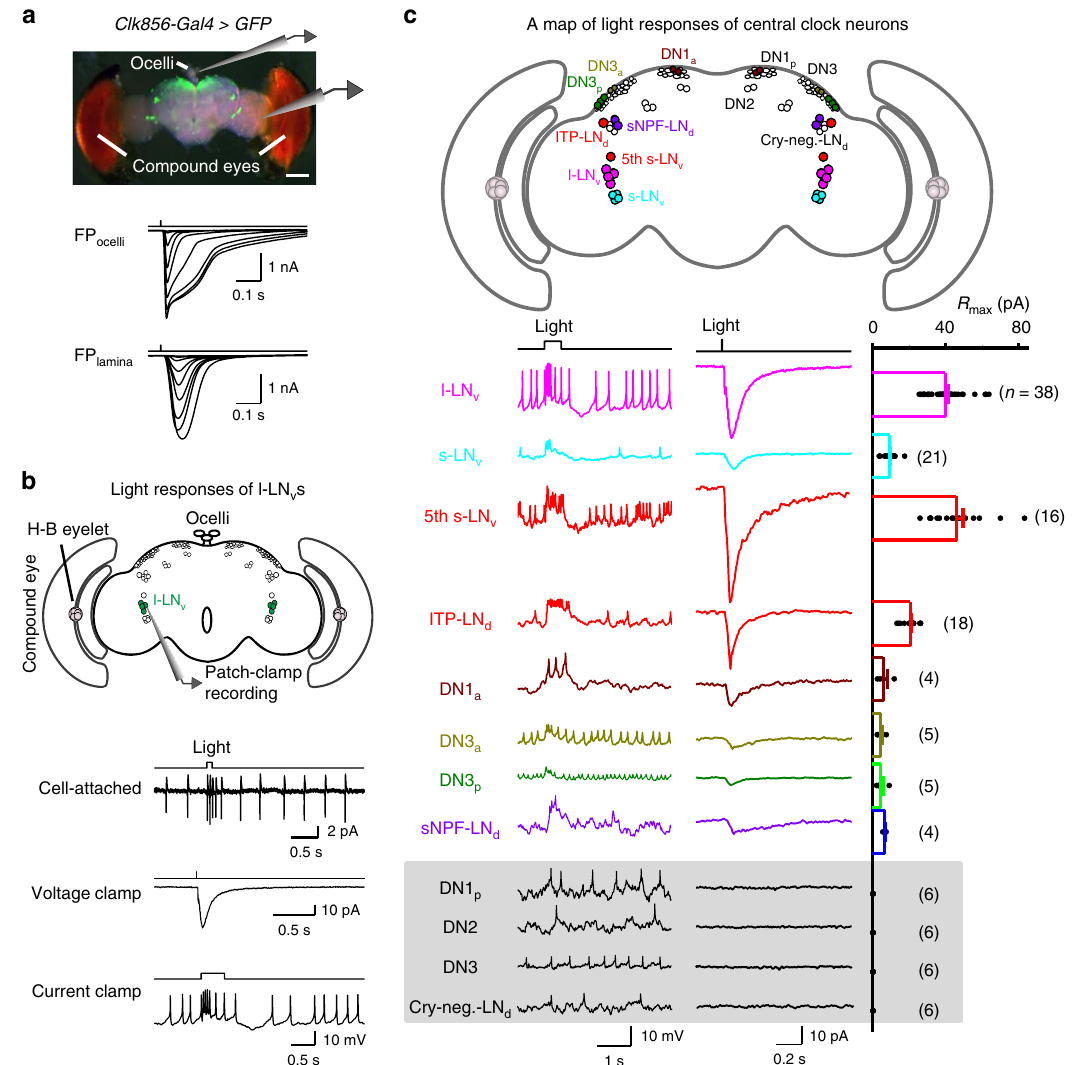
Fig. 2 Light-induced responses are widespread in pacemaker neurons. a A brain preparation for recording light responses of central pacemaker neurons. Top, overlay of bright fi eld and GFP images of a brain preparation. Scale bar, 100 μ m. Middle, families of superimposed fi eld potential of ocelli (FP ocelli ), bottom, fi eld potential recorded in the lamina (FP lamina ). Light stimulation: 2 ms, 470 nm. The timing of fl ashes is indicated on top of the response traces. b Light-induced electrical responses of the l-LNvs. Top, illustration of patch-clamp recordings on the l-LNvs. Bottom three traces are light responses in the cell-attached, voltage clamp (perforated patch-clamp recording), and current clamp (perforated patch-clamp recording) con fi gurations, respectively. Light stimulation: 470 nm. c A map of light responses across pacemaker neurons. Top, schematic distribution of pacemaker neurons. Light-sensitive pacemaker neuron groups are color-coded, but labeled only in the left hemisphere for clarity, and light-insensitive pacemaker neurons are labeled only in the right hemisphere. Bottom, light-induced spike fi ring (current clamp, left), current responses (voltage clamp, middle), and collective data of the maximal current responses (right) of individual pacemaker neurons. DN3a and DN3p cells are recorded in the presence of picrotoxin. Data are represented as average ± SEM. n indicates the cell